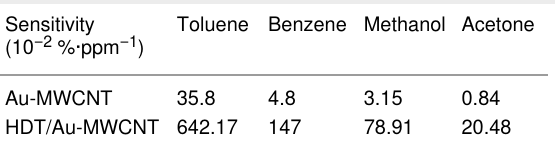
Table 1: Au-MWCNT and HDT/Au-MWCNT sensor sensitivity for aro- matic and nonaromatic vapours.